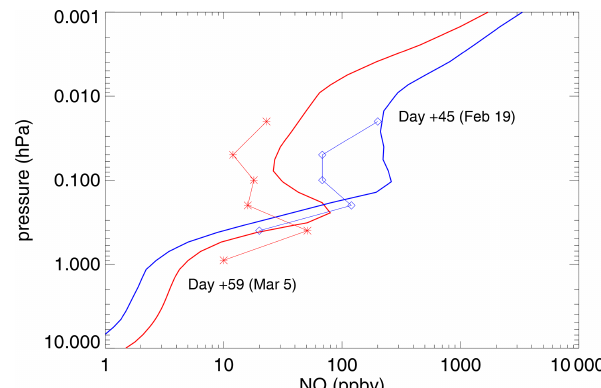
Figure 4. Calculated nitric oxide profiles, averaged from 70 to 90 ◦ N, from WACCMX for the indicated dates to compare with Fig. 3 of Orsolini et al. (2017). The day numbers reflect the con- vention used by Orsolini et al. and are references to the SSW onset on 5 January (Day 0). The actual dates are shown for reference. The symbols are from the SMR data presented by Oroslini et al. (2017) (red stars for 5 March, blue diamonds for 19